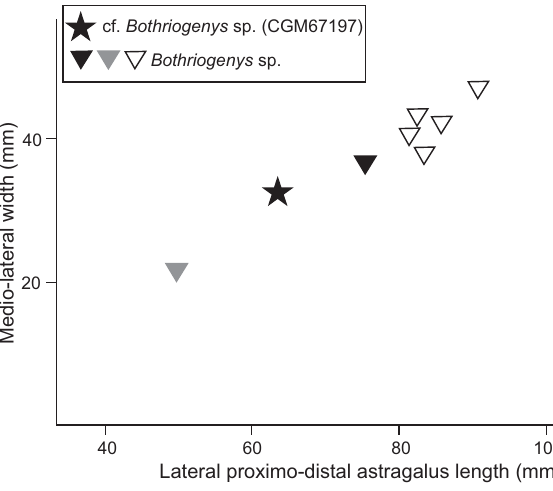
Fig. 11. Bivariate plot of an anthracotheriid astragalus, cf. Bothriogenys sp., from the BOTM, early Oligocene, Minqar Tibaghbagh, Qattara De- pression, Egypt (star), compared with astragali of Bothriogenys sp., from the Jebel Qatrani (black and white triangles) and Qasr El-Sagha (grey tri- angle) formations of the Fayum Depression, Egypt. Original dimensions of the astragalus from Tibaghbagh have been estimated, because of damage. Dimensions of the other astragali are from Andrews (1906: fig. 61, black triangle) and Sileem and Hewaidy (2015: table 1, grey triangle and white